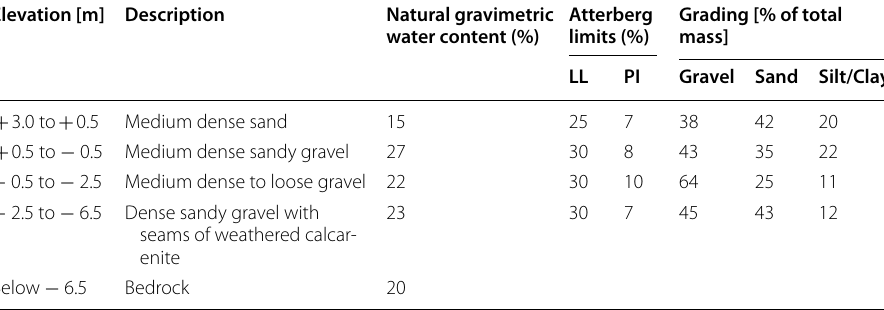
Table 1 Average soil profile of the project (before backfilling) Elevation [m] Description Natural gravimetric